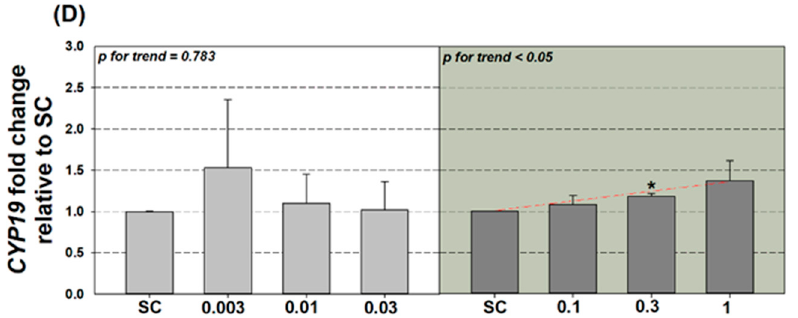
Figure 4. Transcriptional changes of ( A ) STAR , ( B ) 3 β HSD , ( C ) CYP17 , and ( D ) CYP19 genes in H295R cells exposed to DBDPE and BTBPE. The results are shown as mean ± SD of triplicates ( n = 3). Asterisk indicates a significant difference in transcriptional level of treatment groups relative to the solvent control (0.1% DMSO, p < 0.05). The value of p for trend was determined based on the linear regression analysis. If p for trend was < 0.05, a linear trend is indicated with a red dotted line.